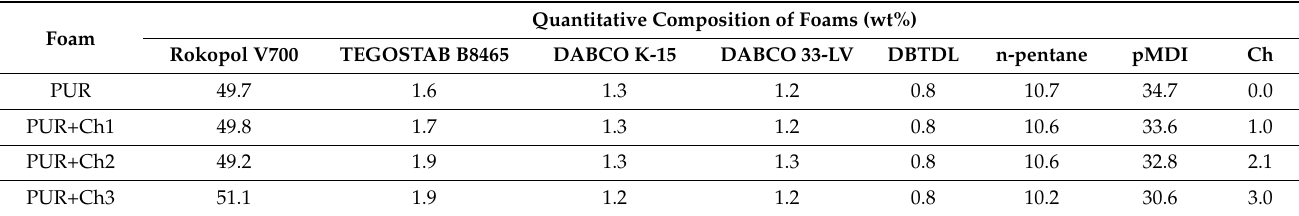
Table 1. Composition of PUR and PUR+Ch